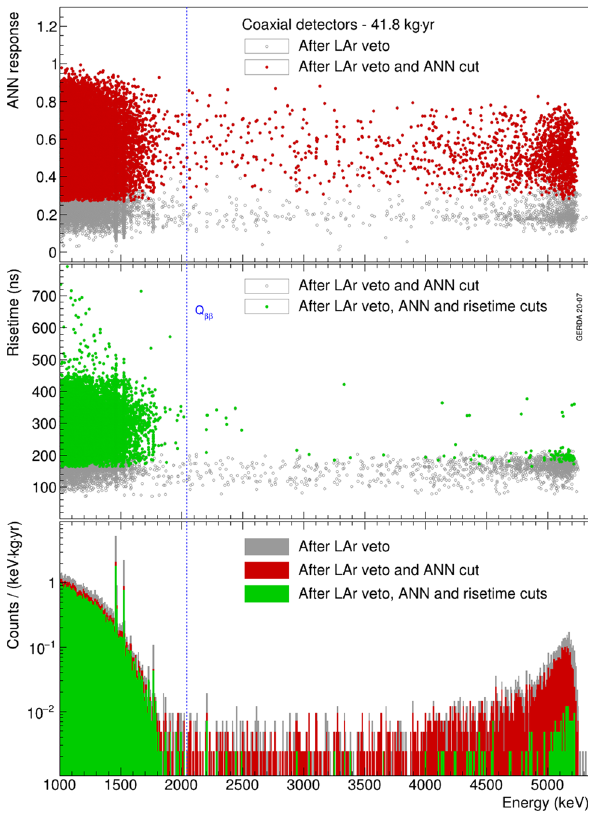
Fig. 18 Top: ANN classifier of physics events from coaxial detectors as a function of energy. Middle: Risetime of events surviving the ANN cut as a function of energy. Bottom: Energy distribution of events from coaxial detectors before and after the ANN and risetime